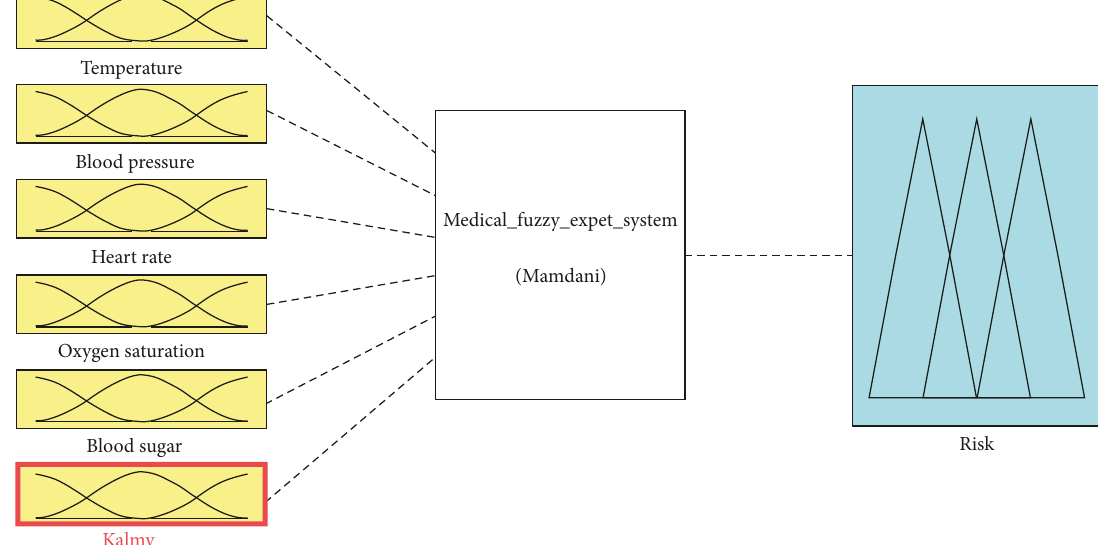
Figure 3: The IFS inference system (input and output).